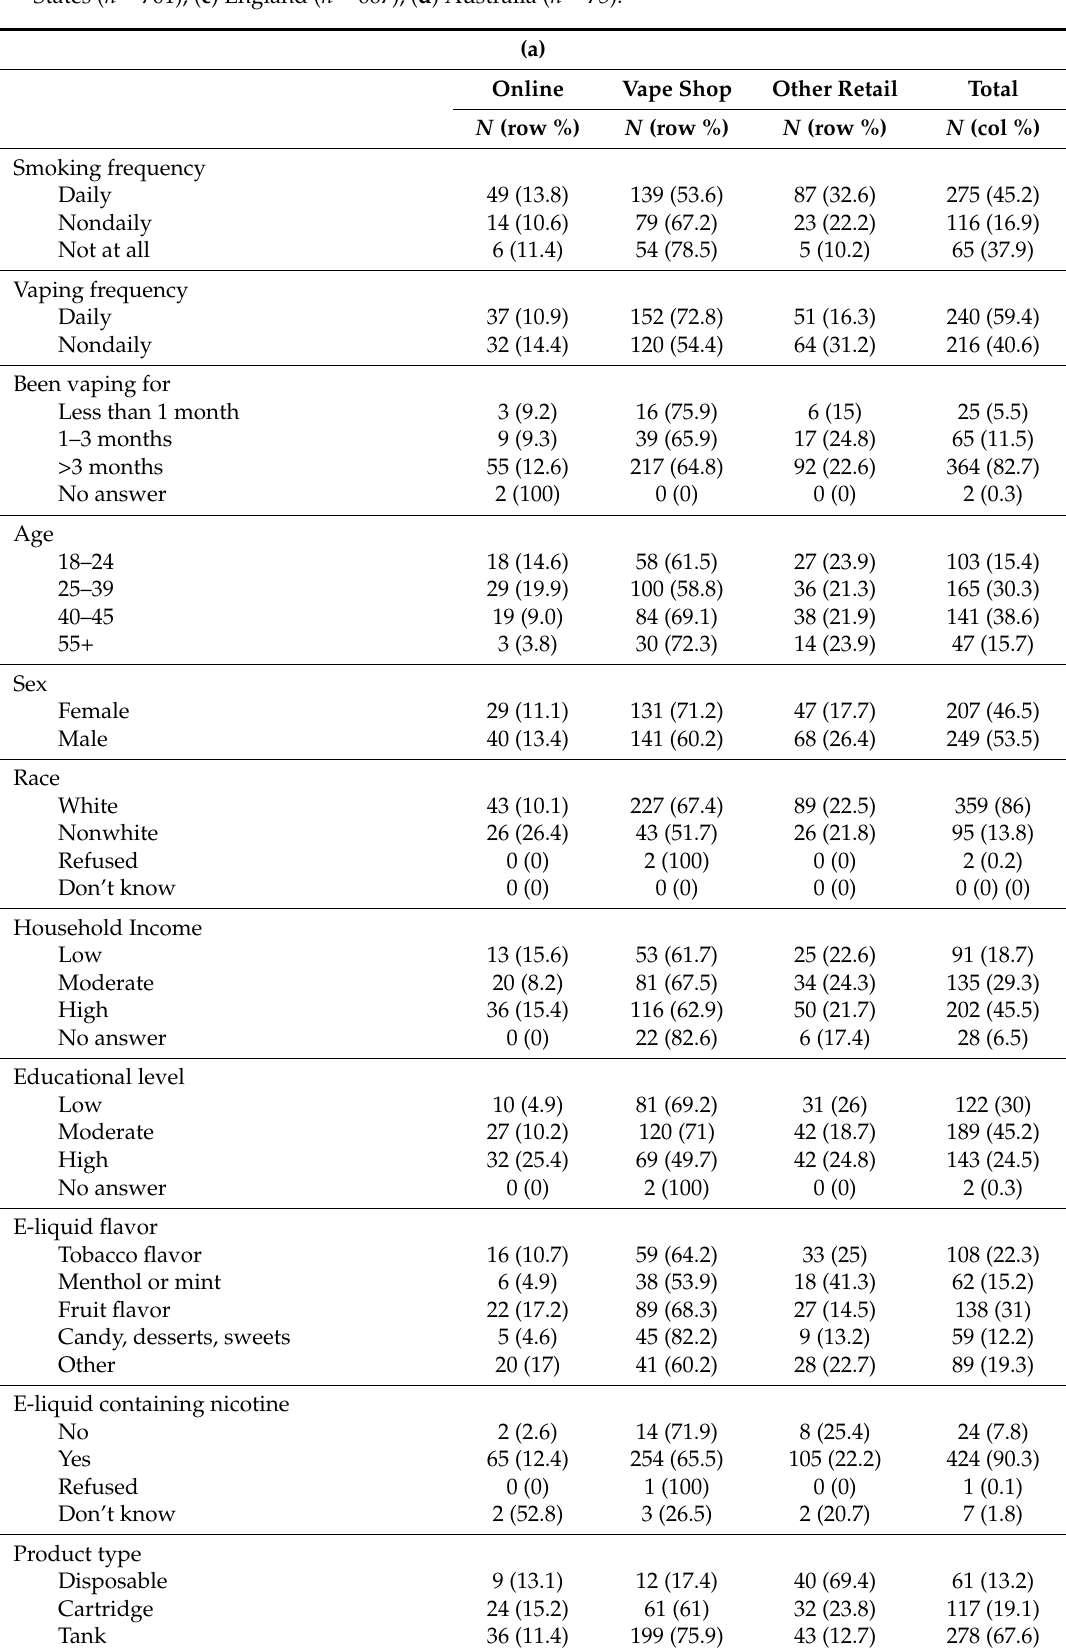
Table 1. Sample characteristics by e-cigarette purchase location in ( a ) Canada ( n = 456); ( b ) the